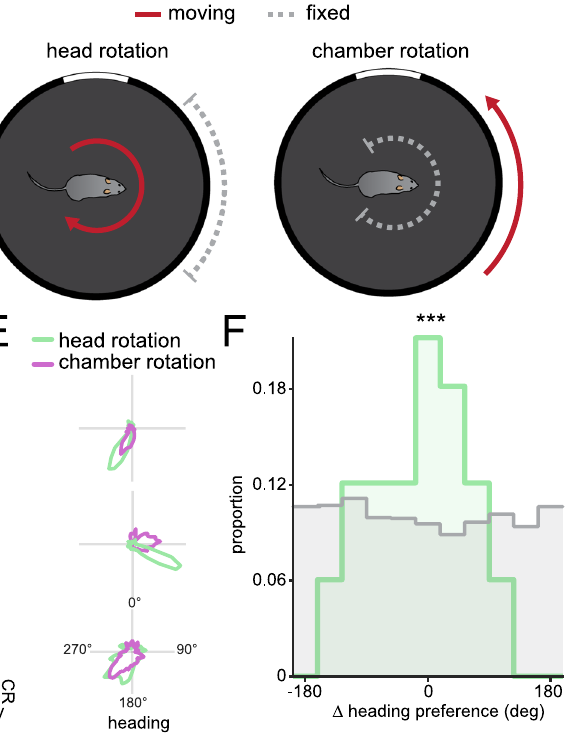
Fig. 2 | Neurons in the RSC retain similar tuning in head-rotation or chamber- rotation conditions. A Example of the adapted head-rotation set-up for compar- isons betweenhead-rotation and chamberrotationexperiments.In additionto the motor-driven wheel that can rotate the chamber while the head is immobilized, there is a separate rotation collar that can be used to rotate the mouse over the stationary chamber. Inset: Zoomed in image of the rotation collar assembly. The rotationcollarcontainsanx-ytranslatortoshifttheaxisofrotationtothecenterof theimaging fi eld.Abelt-driveconnectsthecollartoamotorforcontrolledrotation. B Schematic of the two experimental conditions. Either the chamber or the head rotatesindependently, shownwith aredarrow,whilethe otherremainsstationary, shownwithadashedgraycappedline.Inbothcases,thiscausesthevisualcuecard to move across the visual fi eld in the same direction. C Example of derotation process for image timeseries. Each of the three raw images is rotated to matchthe template on the right. Colored borders show the position and rotation of each